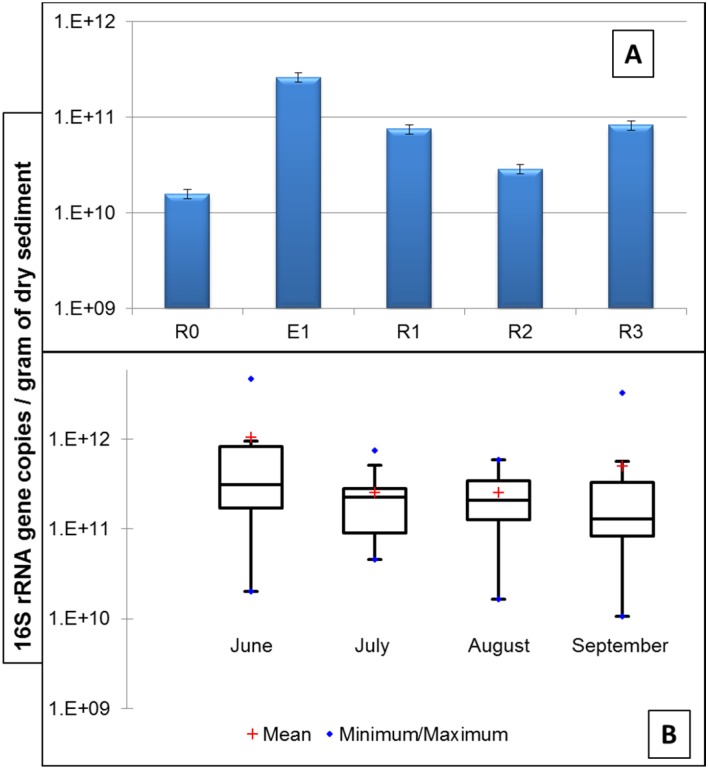
qPCR quantification of 16S rRNA gene in the surface sediment samples of CRB (A) and HOP (B).Values (log transformed) are expressed for the copy number per gram of sediment dry weight normalized to the DNA extraction yield. The box plot represents the first and third quartile, the blue dots on maximum/minimum values and the red cross indicate mean.